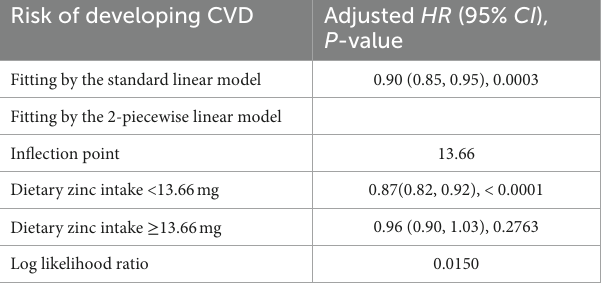
TABLE 4 Threshold effect analyses of dietary zinc intake on the risk of new-onset CVD using 2-piecewise regression models. Risk of developing CVD